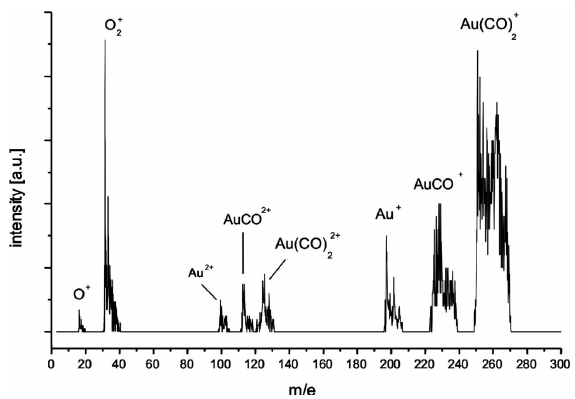
Figure 15. Chemical probing of the carbonyls-wave by PFDMS: Mass spectrum acquired on an Au tip during the wave propagation (see Figure 14) and highlighting the presence of an Au-carbonyls wave and oxygen as imaging gas The region of analysis corresponds to ≈ 300 atomic Au sites. Conditions of acquisition: T = 300 K, P CO = 2 × 10 − 5 Pa, P O = 10 − 2 Pa, steady field F R = 1.2 V/Å, pulsed field F P = 2.5 V/Å, frequency of the field pulses f = 10 Hz. Reprinted from [201], Copyright 2006, AIP Publishing.